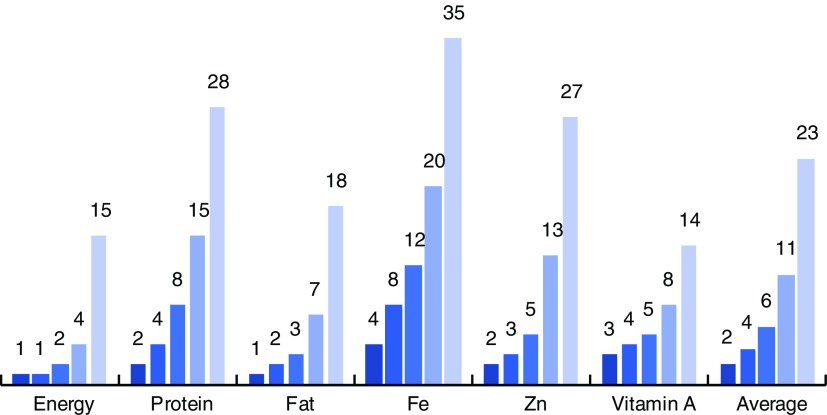
(colour online) Number of foods (out of a total of ninety-four) required to meet different levels of total intake (, 50 %; , 60 %; , 70 %; , 80 %; , 90 %), by nutrient, among 6374 Bangladeshi households using data from the 2011/12 Bangladesh Integrated Household Survey (BIHS)